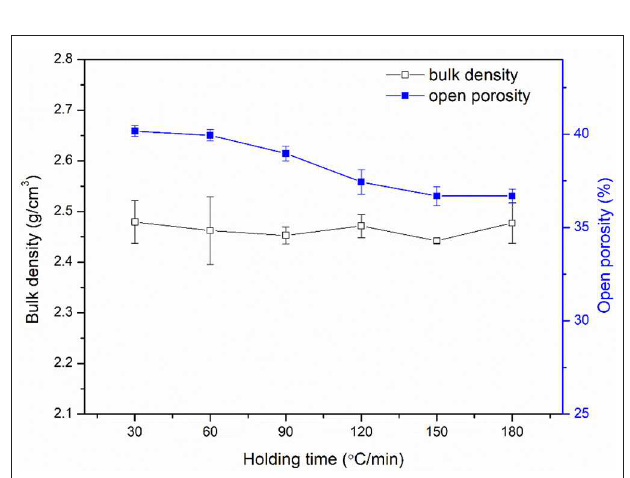
FIGURE 10 | XPS curves of alumina ceramic sintered with different holding times.